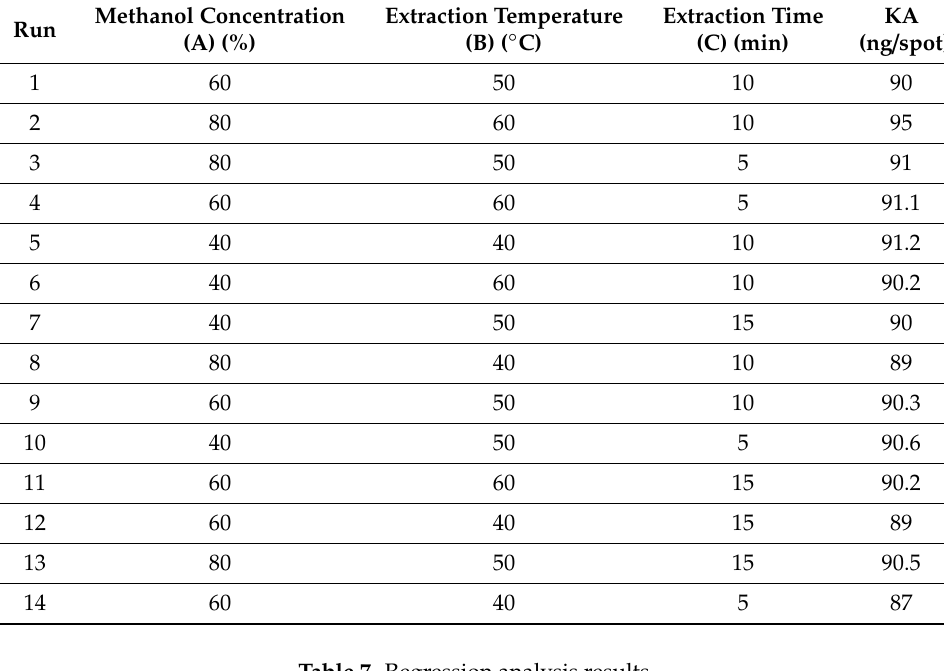
Table 6. Box–Behnken design (BBD) matrix for the optimization of extraction of KA yield (ng / spot).